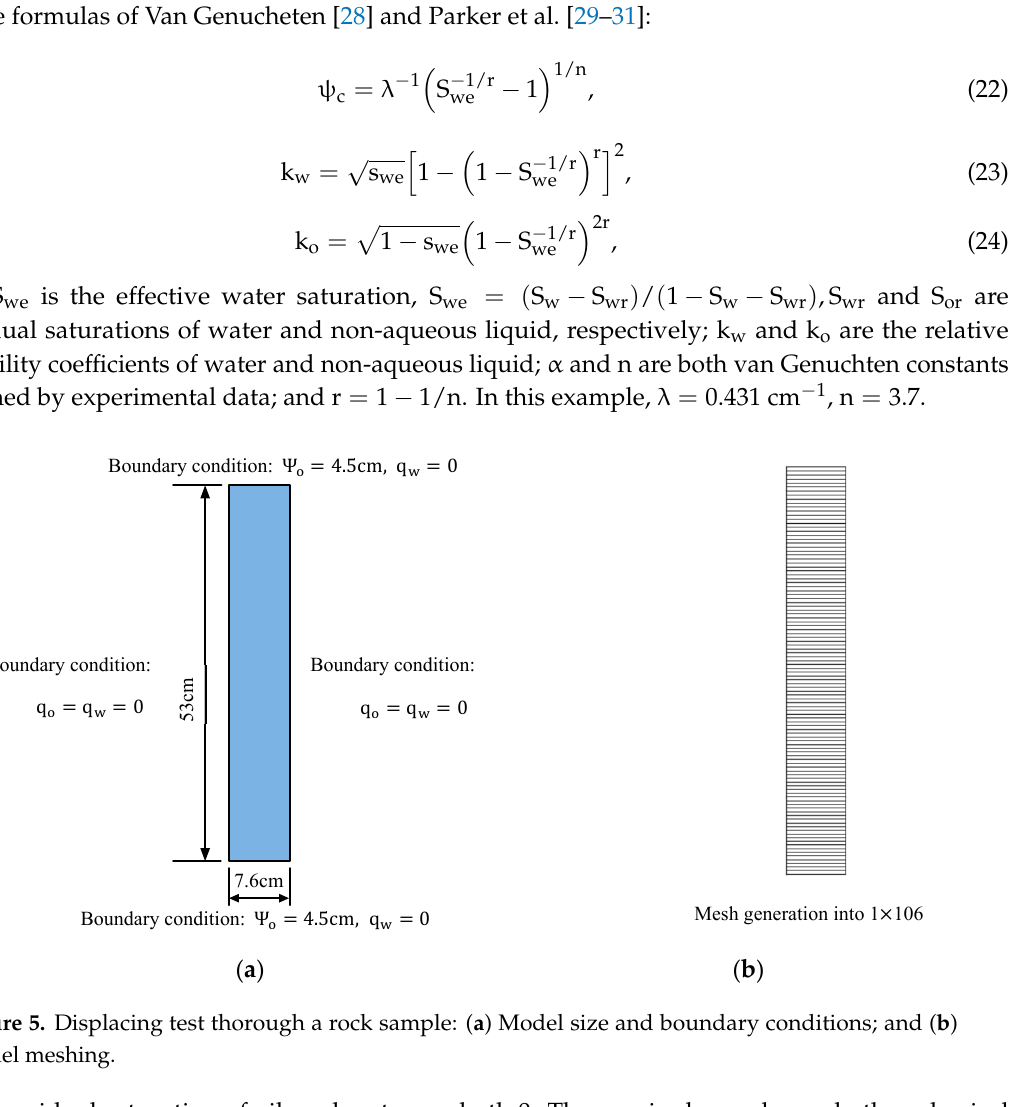
Table 1. Physical properties of rock sample and fluids (24 °C).